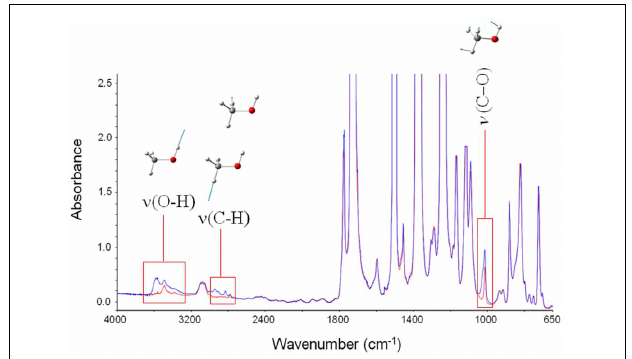
Figure 1 | Absorbance spectra for fully dried PMDA-ODA (red trace) and PMDA-ODA equilibrated at p / p 0 = 0 . 5. The insets represent the bands characteristic of sorbed methanol, and the forms of the respective normal